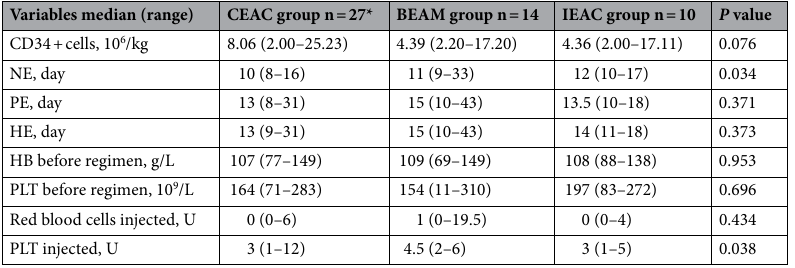
Table 2. Transplant-related results in 51 patients. *One patient in CEAC group was excluded from the analysis due to death before HE. NE, Neutrophil engraftment; PE, platelet engraftment; HE, hematopoietic